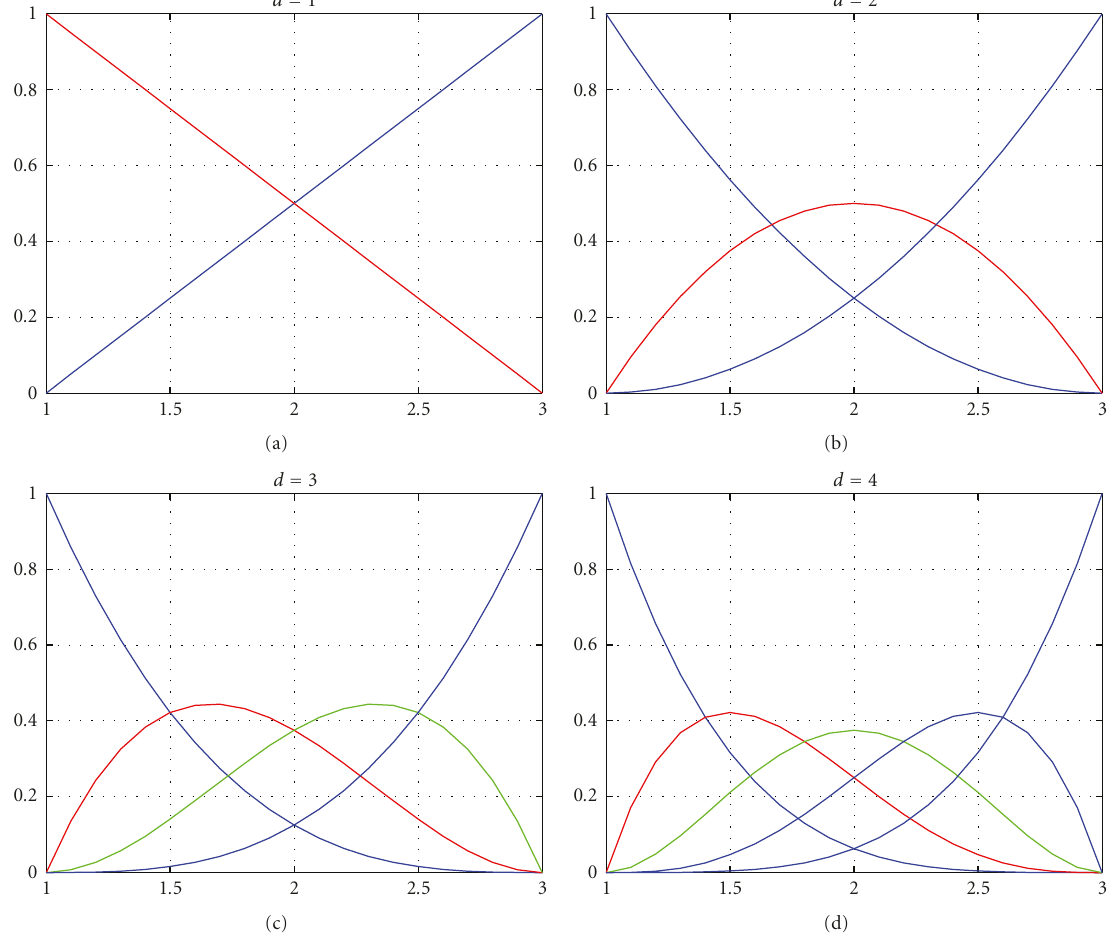
Figure 1: Nonuniform spline bases for d = 1, d = 2, d = 3 and d =